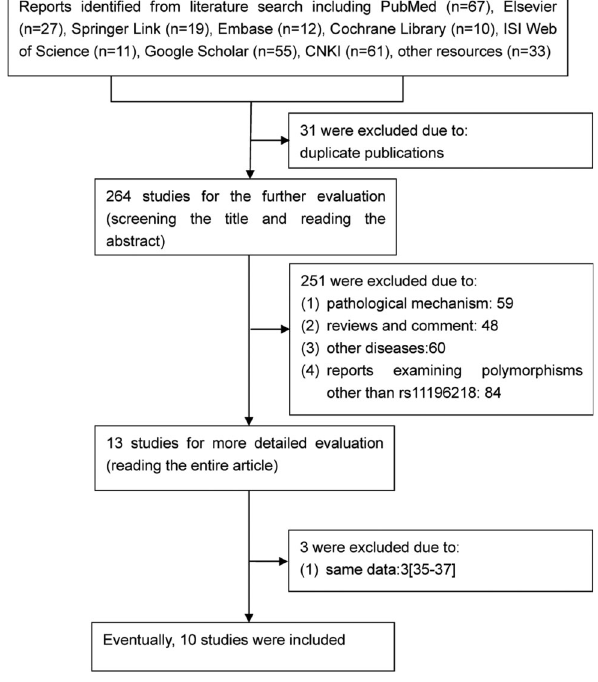
Figure 1 - Selection of the included